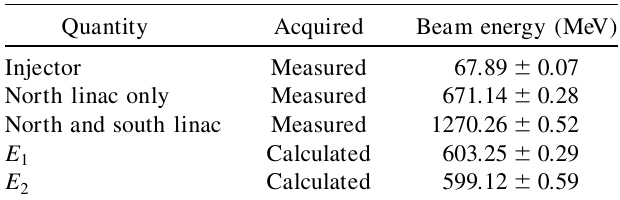
TABLE IX. Summary of measurements to determine the linac energy imbalance.